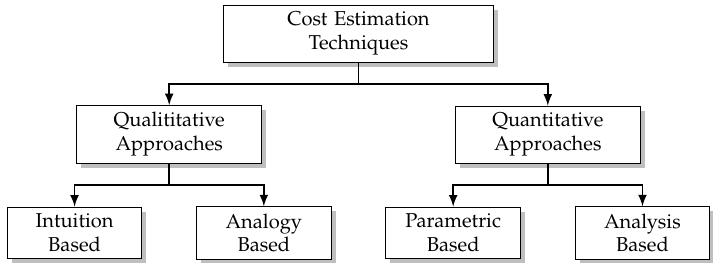
Figure 1. Classification of product cost estimation based on Niazi et al.